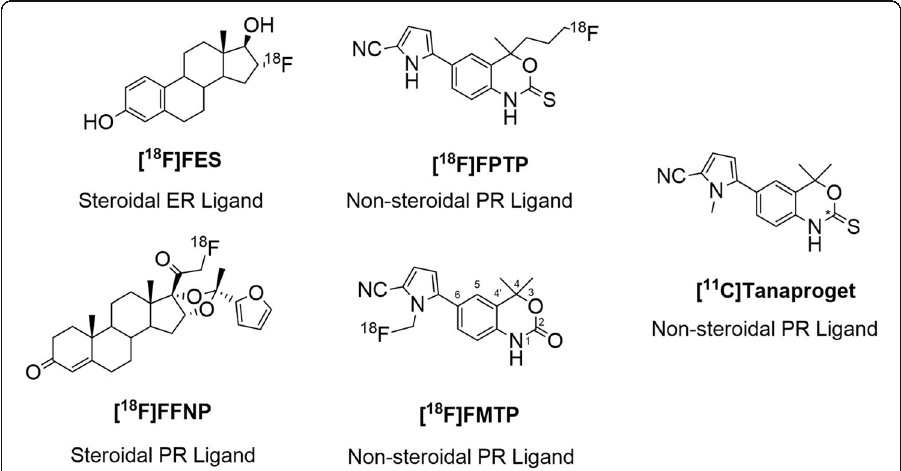
Fig. 1 Structures of steroid hormone receptor radioligands: 16 α -[ 18 F]fluoro-17 β -estradiol ([ 18 F]FES),